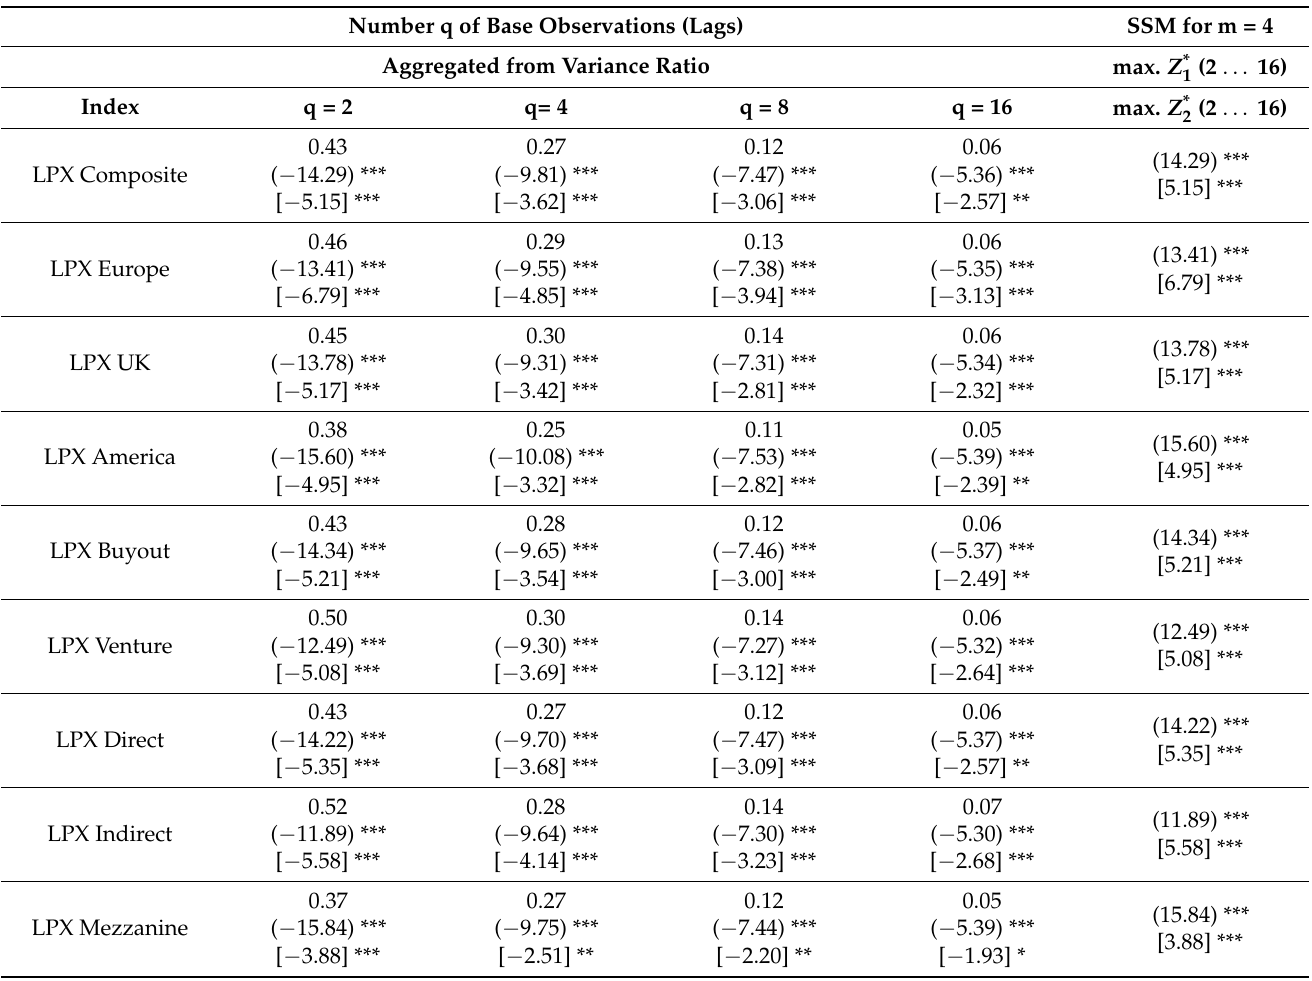
Table 6. Variance ratio estimates VR(q) and variance ratio test statistics for listed private equity index returns during